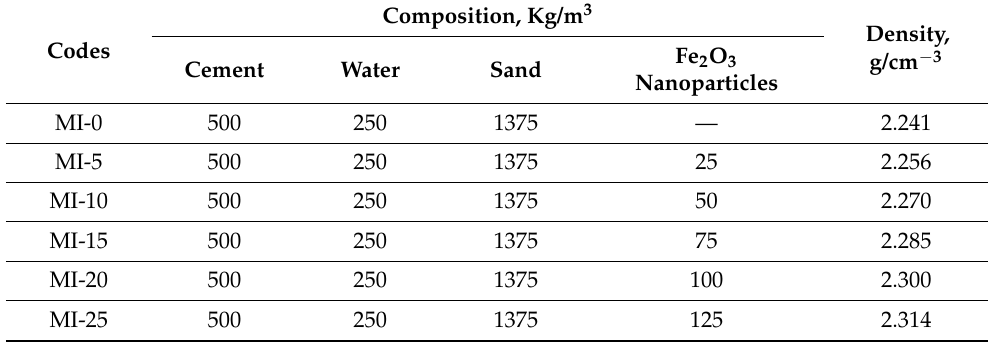
Figure 1. The mortar samples used in the radiation attenuation measurements.